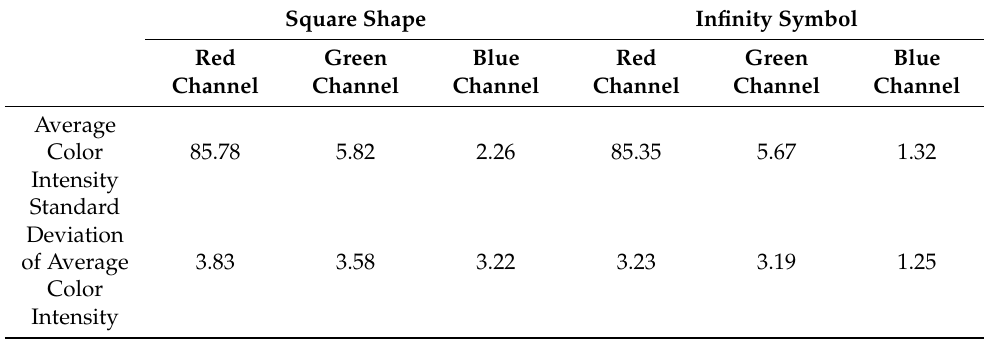
Table 2. Color intensity measurement of square shape and infinity symbol patterns.